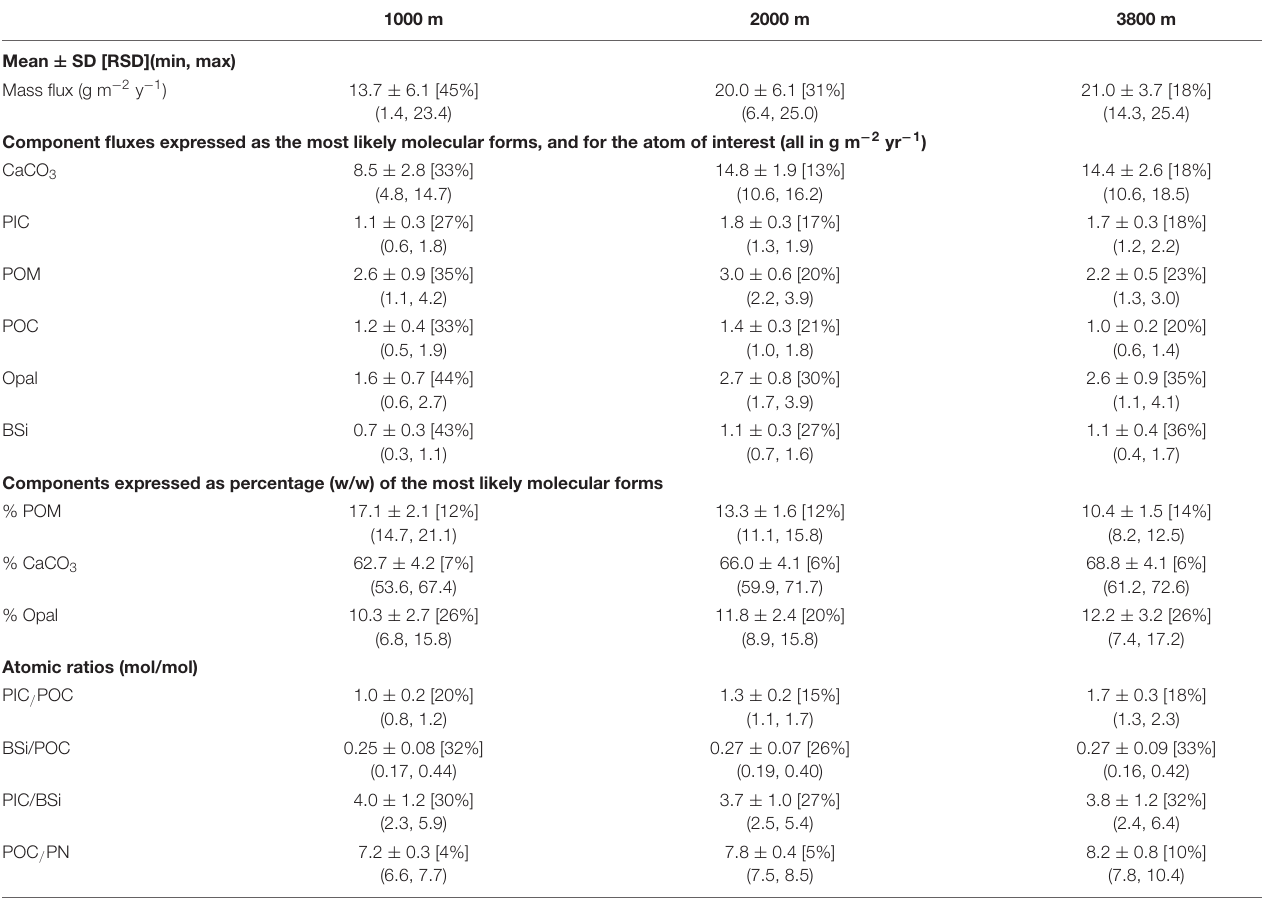
TABLE 1 | SOTS average particle fluxes and compositions for the years with full records, minimum and maximum values in brackets, relative standard deviation expressed as percentage in square